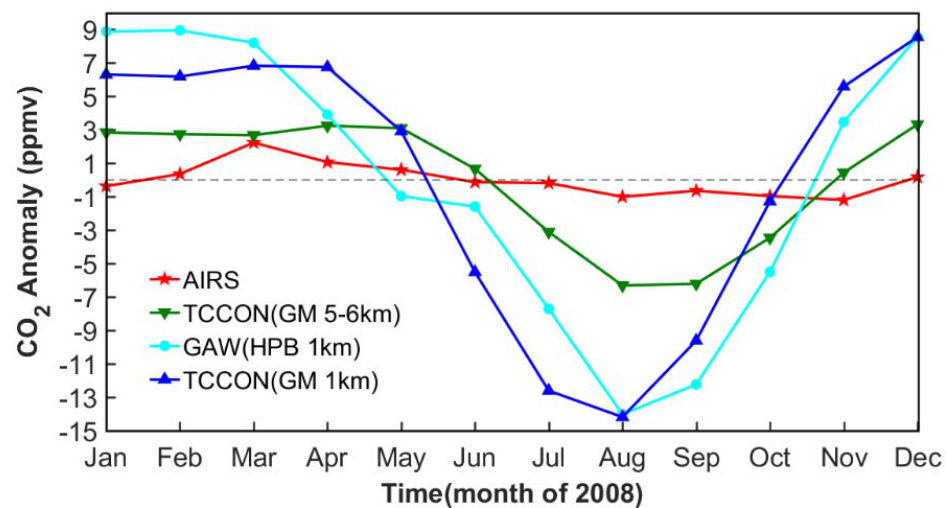
Figure 10. CO 2 amplitude of the AIRS, TCCON (GM 5–6 km), GAW (HPB 1 km) and TCCON (GM 1 km) over 2008. over